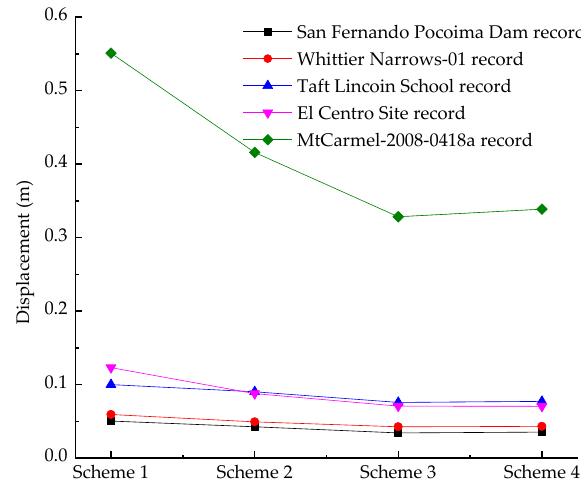
Figure 12. Beam-end longitudinal displacement.